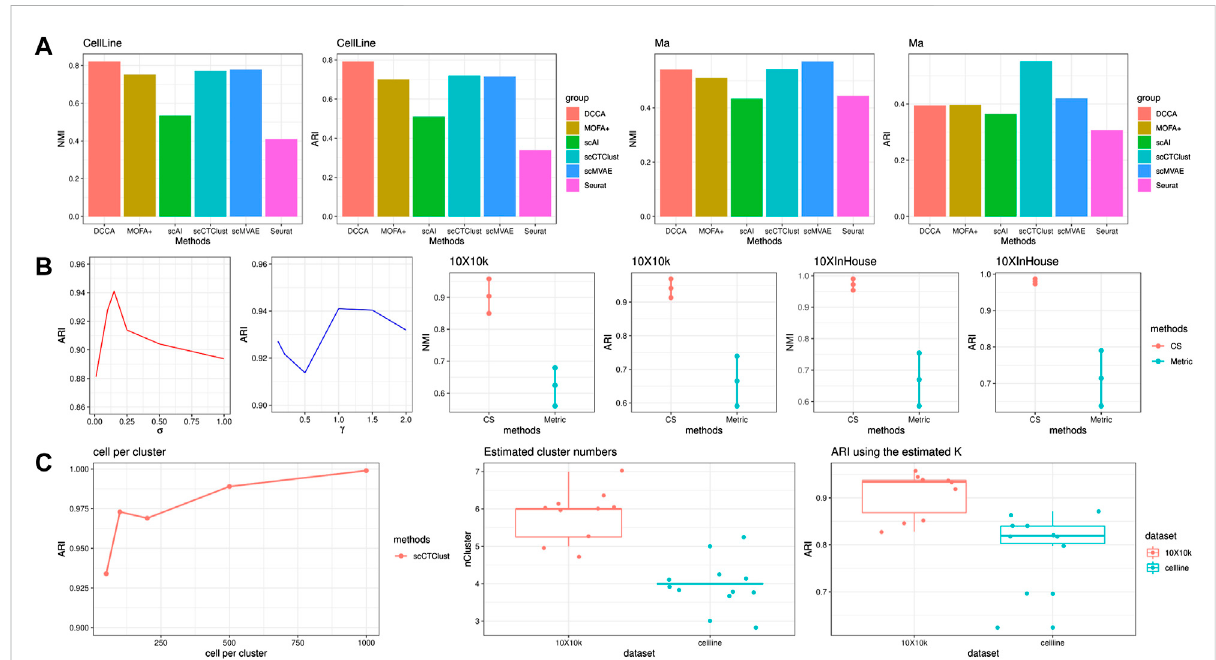
FIGURE 4 SNARE-seq experiments andablationstudies. (A) PerformanceofscCTClustand competing methods byNMIand ARIovertheSNARE-seqdata set CellLine and SHARE-seq data set Ma. (B) Ablation study to determine the robustness of hyperparameters and the advantages of C-S divergence- based clustering against metric-based clustering. (C) Performance of scCTClust over different scales of simulated data sets. The estimated number of clusters and clustering results were obtained with